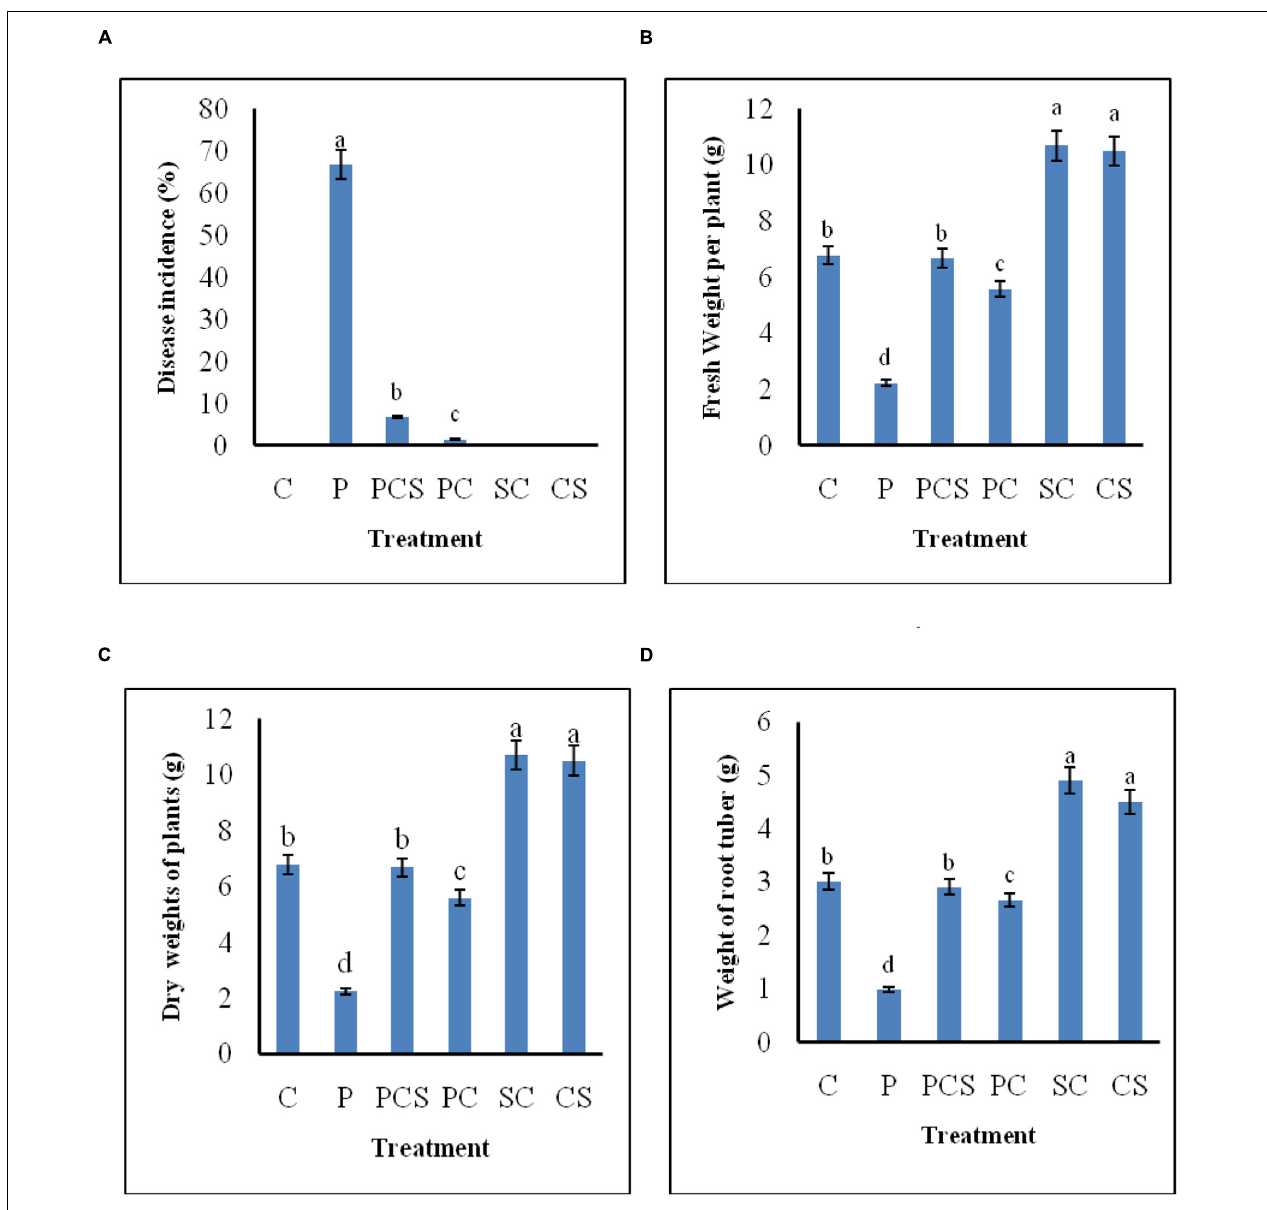
FIGURE 6 | Effect of S. hydrogenans and its culture filtrate as foliar treatments on R. sativus to control A. brassicicola causing black leaf spot disease. (A) Percentage of disease incidence (B) fresh weight of plants (C) dry weight of plants (D) weight of root tuber. Error bars represent approximate 95% confidence limit. Same letters on the bar are not significantly different according to Tukeys test ( p ≤ 0.01); C, Control (Water only); P, Pathogen only; PE, Pathogen + Extract; PC, Pathogen + Streptomyces cells; SC, Streptomyces cells